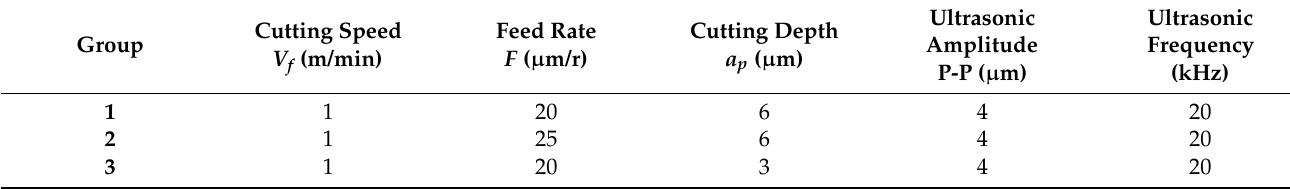
Table 2. Cutting parameter setting.